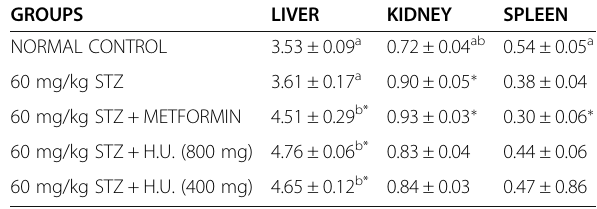
Table 5 Relative organ weight GROUPS LIVER KIDNEY